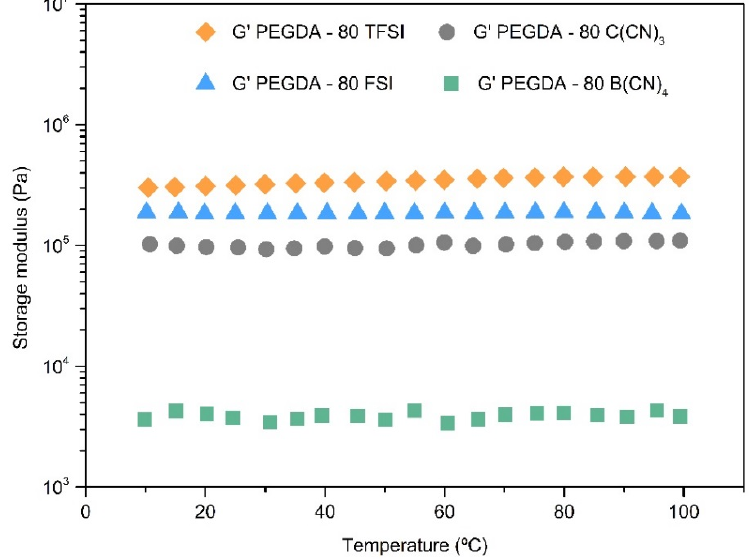
Figure 5. Storage modulus as a function of temperature of the iongels (80 wt % IL) bearing di ff erent anions.